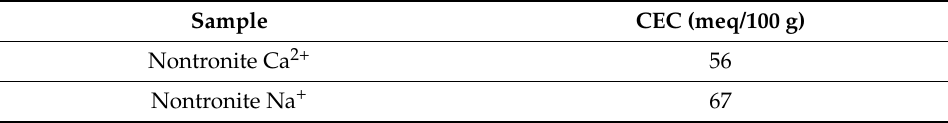
Figure 7. Cation exchange capacity testing. ( a ). Nontronite Ca 2+ . ( b ). Nontronite Na + . Table 2. Details of the cation exchange capacity of the clays.